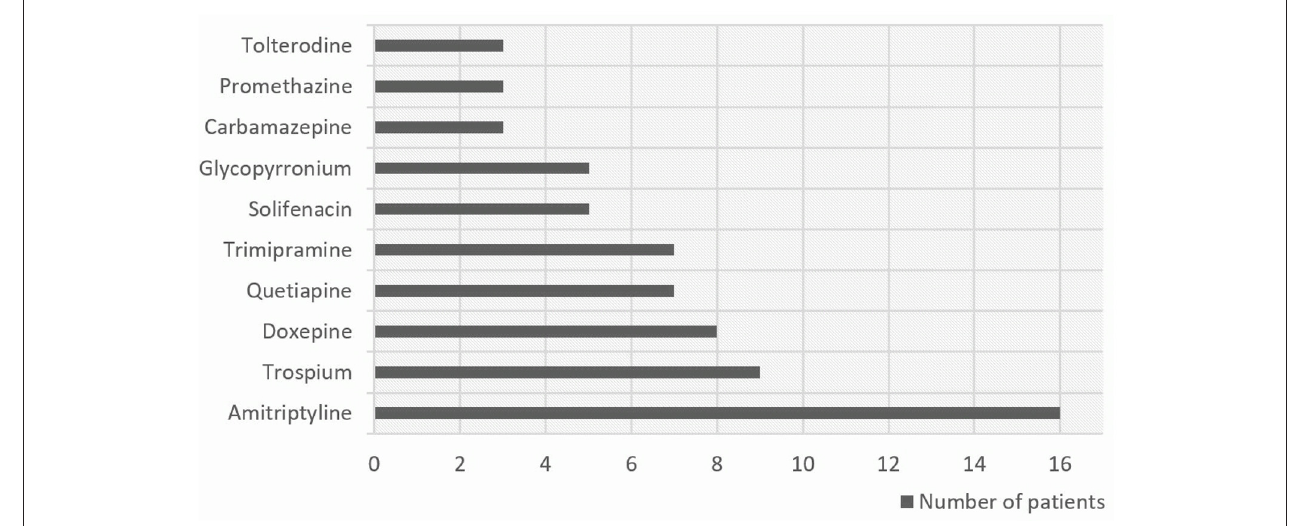
FIGURE 1 | The ten most prescribed DAPs in our study population according to the Anticholinergic Burden Score (ABS).